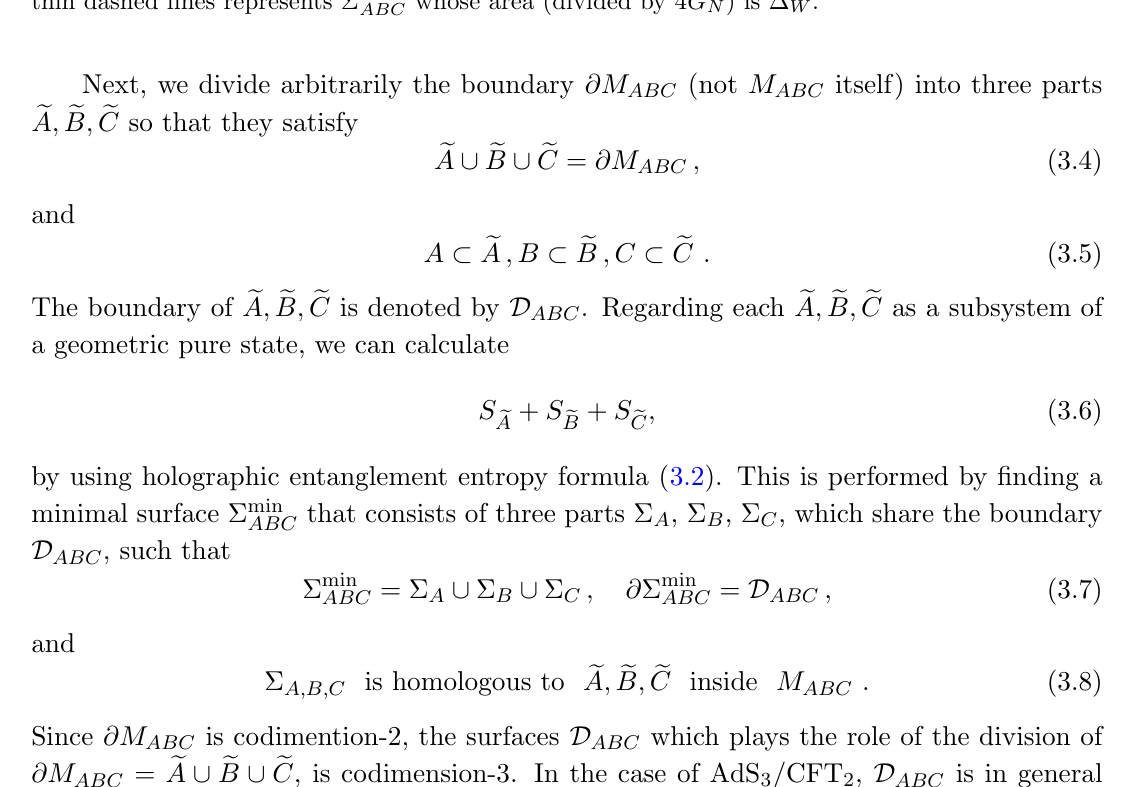
Figure 2 . An example of tripartite entanglement wedge cross-section. The black bold dashed lines represents the minimal surface (cid:0) min , giving a part of the boundary of M ABC . The yellow ABC thin dashed lines represents (cid:6) min whose area (divided by 4 G N ) is (cid:1) W ABC